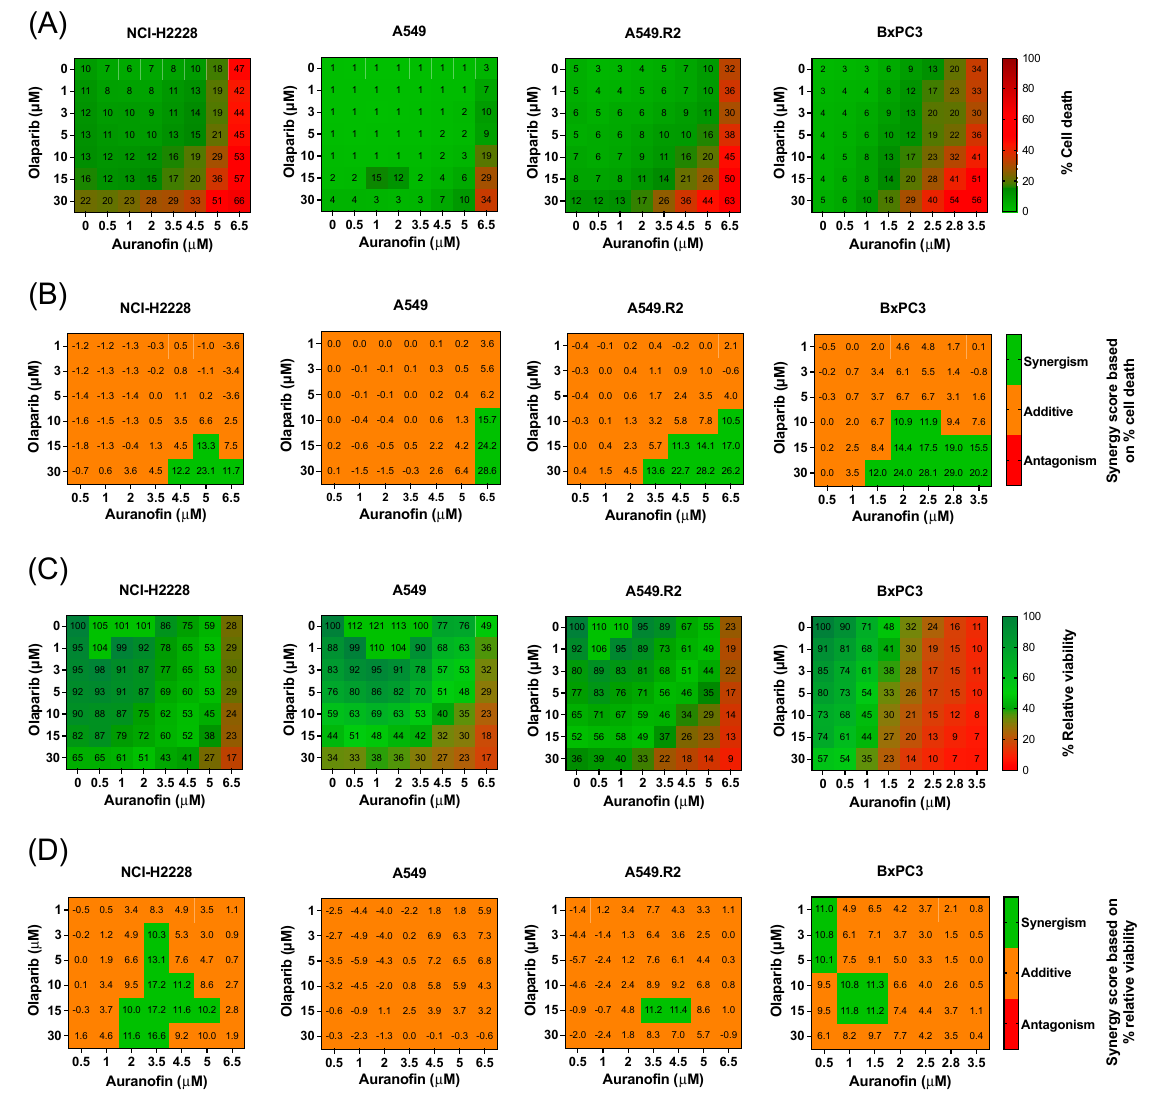
Figure 2. Cytotoxic multi-drug response to aurola treatment in NSCLC and PDAC cell lines in vitro. ( A ) Heatmap representing the cytotoxic effect of AF (0–6.5 µM) and olaparib (0–30 µM) monotherapy and their combinations after 72 h in the NSCLC cell lines NCI-H2888, A549, and A549.R2 and the PDAC cell line BxPC3. ( B ) Synergy scores for each concentration of AF and olaparib in the combination after 72 h of treatment in the NSCLC cell lines NCI-H2888, A549, and A549.R2 and the PDAC cell line BxPC3. Scores were based on drug combination response normalized to percentage inhibition (cell death). Synergy score > 10: synergistic interaction (green). Synergy score − 10 to 10: additive interaction (orange). Synergy score < − 10: antagonistic interaction (red) between two drugs. ( C ) Heatmap representing the relative viability of the NSCLC cell lines NCI-H2888, A549, and A549.R2 and the PDAC cell line BxPC3 after 72 h of treatment with AF (0–6.5 µM) and olaparib (0–30 µM) monotherapy and their combinations. ( D ) Synergy scores for each concentration of AF and olaparib in the combination after 72 h of treatment in the NSCLC cell lines NCI-H2888, A549, and A549.R2 and the PDAC cell line BxPC3. Scores were based on drug combination response normalized to percentage viability. Synergy score > 10: synergistic interaction (green). Synergy score − 10 to 10: additive interaction (orange). Synergy score < − 10: antagonistic interaction (red) between two drugs. Experiments were performed at least in triplicate. Representative images showing the effect of AF, olaparib, and aurola on the number of dead NSCLC and PDAC cells are shown in Figure S3.